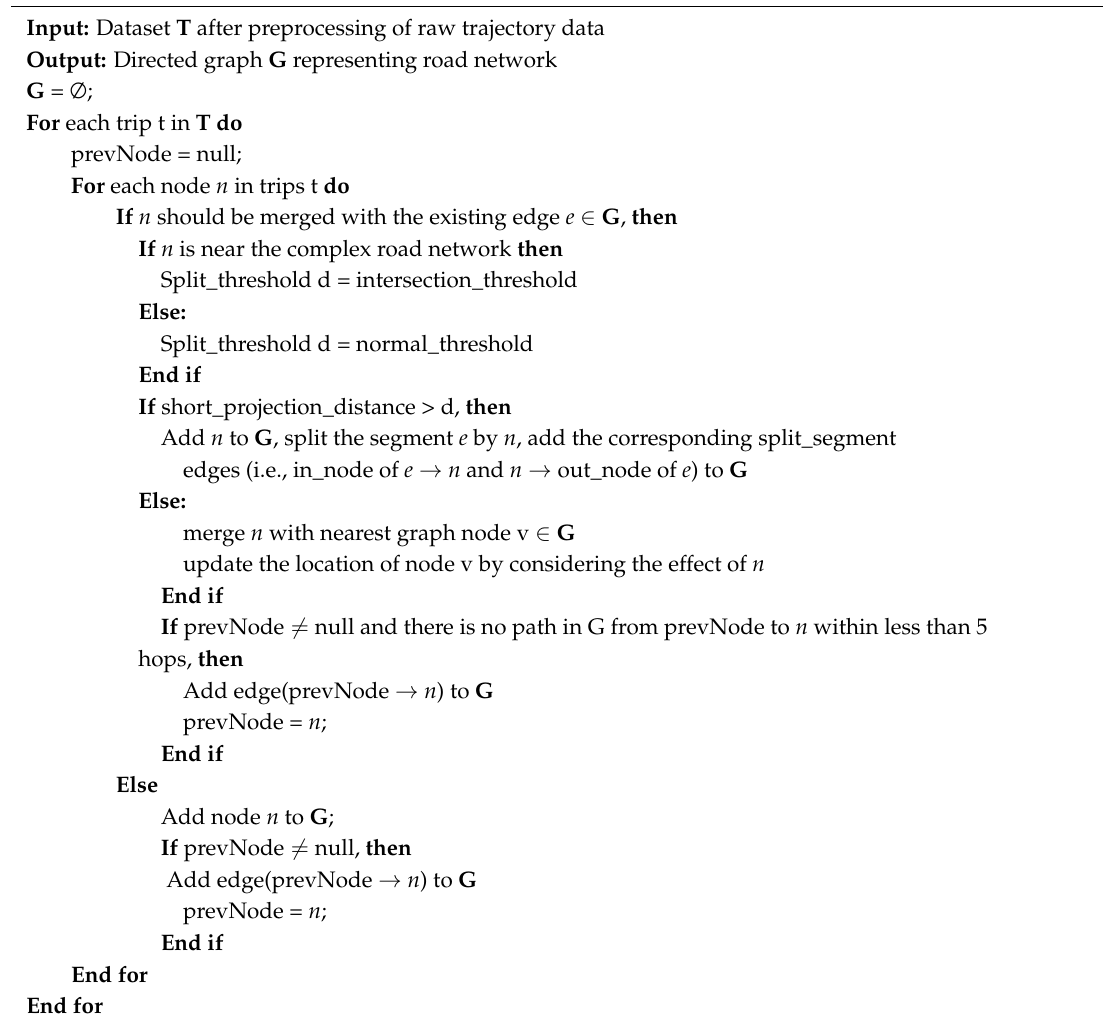
Algorithm 2 Road network construction from dataset of